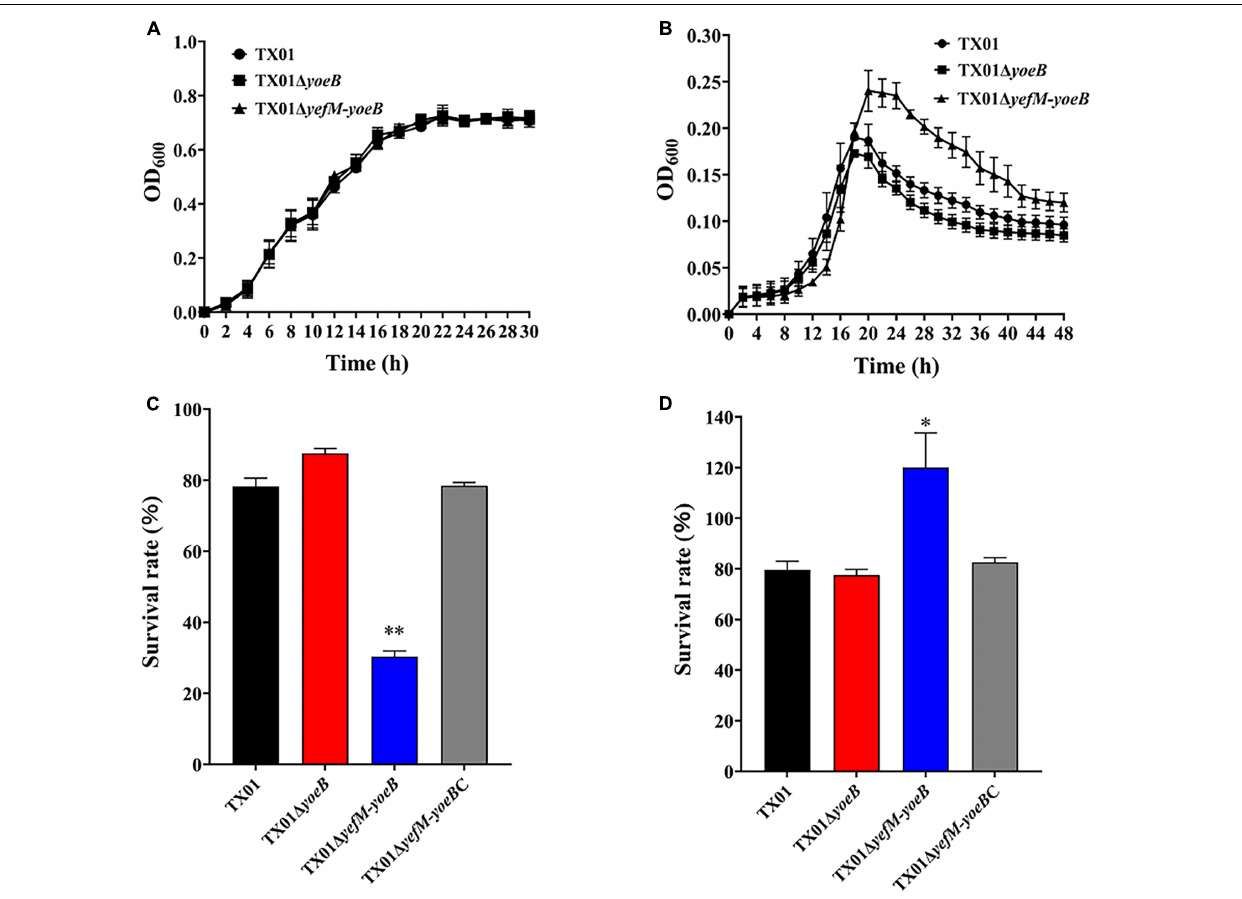
FIGURE 3 | Sensitivity of Edwardsiella piscicida to stress. (A) The growth curve of TX01, TX01 (cid:49) yeoB , and TX01 (cid:49) yefMyeoB in LB medium under normal condition. (B) The growth curve of TX01, TX01 (cid:49) yeoB , and TX01 (cid:49) yefMyeoB in LB medium under high temperature (40 ◦ C). (C) The survival rate of TX01, TX01 (cid:49) yeoB